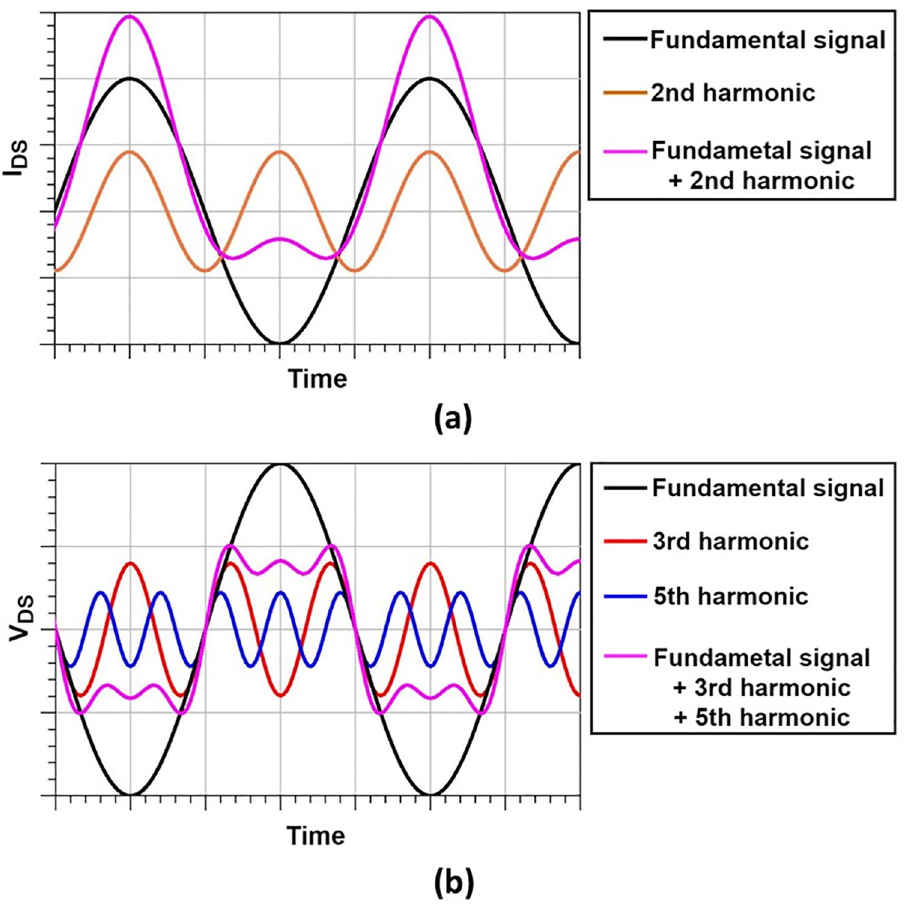
Fig 2. The principles by which waveforms are transformed by harmonics. The V DS is formed by the original signal and the odd harmonic, and the I DS is formed by the original signal and the even harmonic.